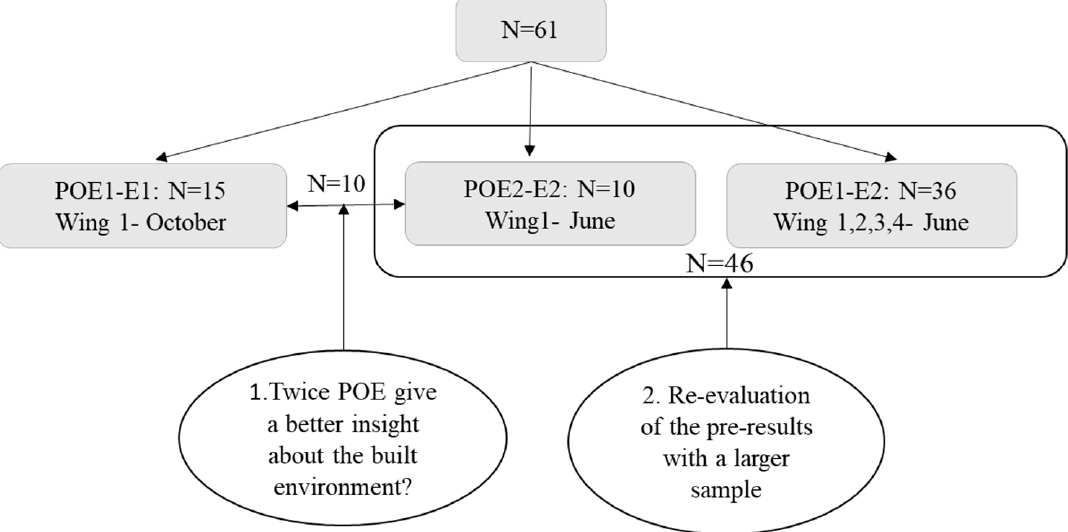
Figure 2. Three main research questions and the results of POE vs. PM comparison for different groups of participants during the first and second times (October and June).